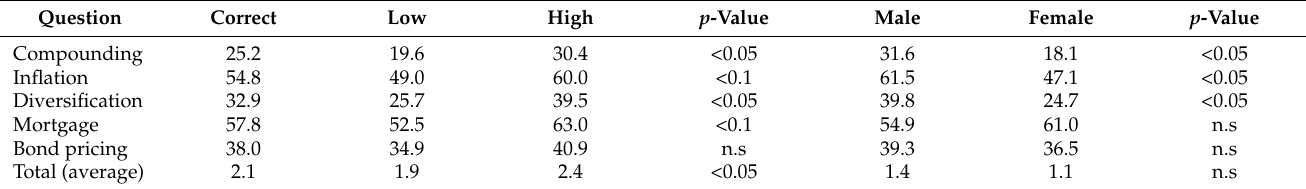
Table A6. Financial literacy questions (of correct questions by CRT group, gender and total, %).